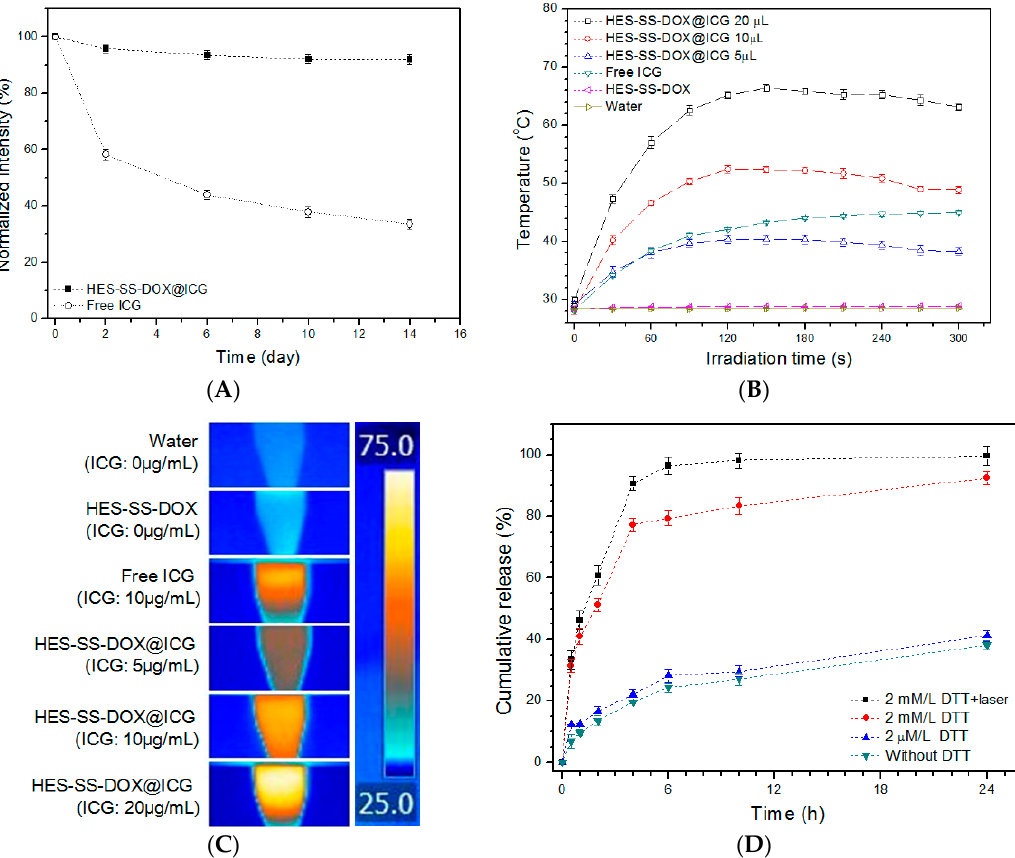
Figure 2. UV absorbance intensity ( A , in PBS) detected at different time points after preparation of the stock solutions. Photothermal profiles ( B , in deionized water, concentration of free ICG solution: 10 μ g/mL) of different samples, infrared themographic images ( C , photos were taken at the moment after 5-min irradiation) of different samples, and cumulative release ( D ) of DOX from HES-SS-DOX@ICG NPs at different DTT concentrations but at a fixed pH of 7.4 with or without laser irradiation (irradiation intensity and time for all involved cases were 0.75 W/cm 2 and 5 min. The ratio of DOX to ICG for the related cases was 2.3).